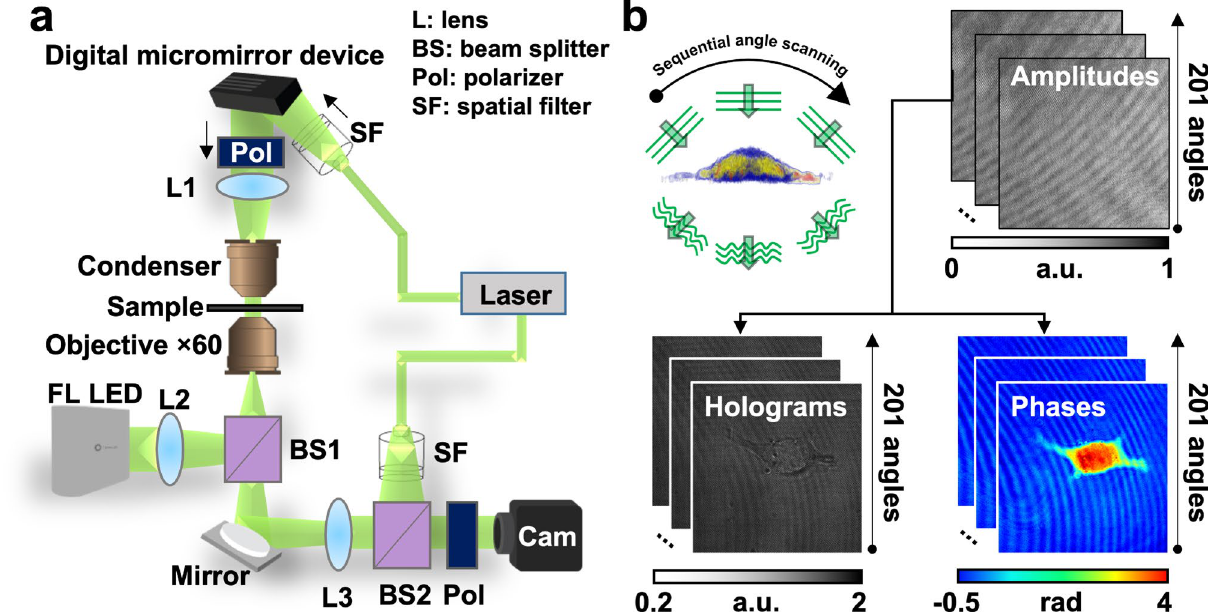
Figure 1. Schematic diagrams of three-dimensional (3D) optical diffraction tomography (ODT) microscopy. ( a ) Optical assembly of an ODT microscope. ( b ) A representative sample cell is shown. Label-free ODT produces a refractive index (RI) distribution by assembling the RI range of images acquired from 201 sequential angles scanned from two-dimensional